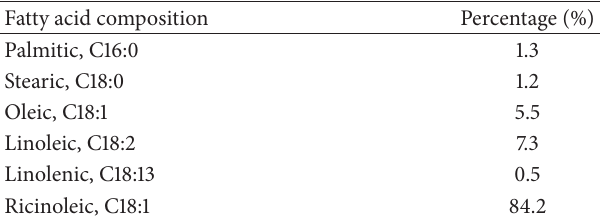
Table 1: Fatty acids composition of Malaysian castor seed oil